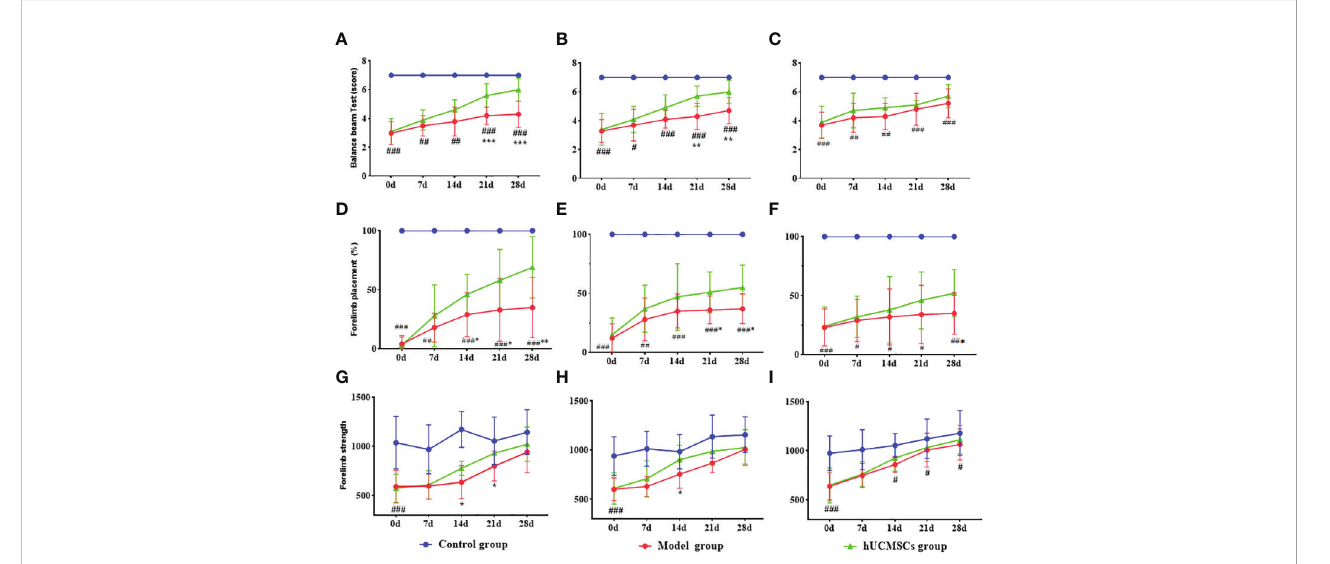
FIGURE 7 Effect of hUCMSCs administration on the neurologic/motor recovery of MCAO rats at different administration time points. (A – C) Balance beam test scores after administration on d4, d7, and d14 post-modeling. (D – F) Forelimb placement scores after administration on d4, d7, and d14 post-modeling. (G – I) Forelimb muscle strength scores after administration on d4, d7, and d14 post-modeling. Data are presented as mean ± SD. # P < 0.05, ## P < 0.01, and ### P < 0.001 vs control group; **P < 0.01, ***P < 0.001 vs model